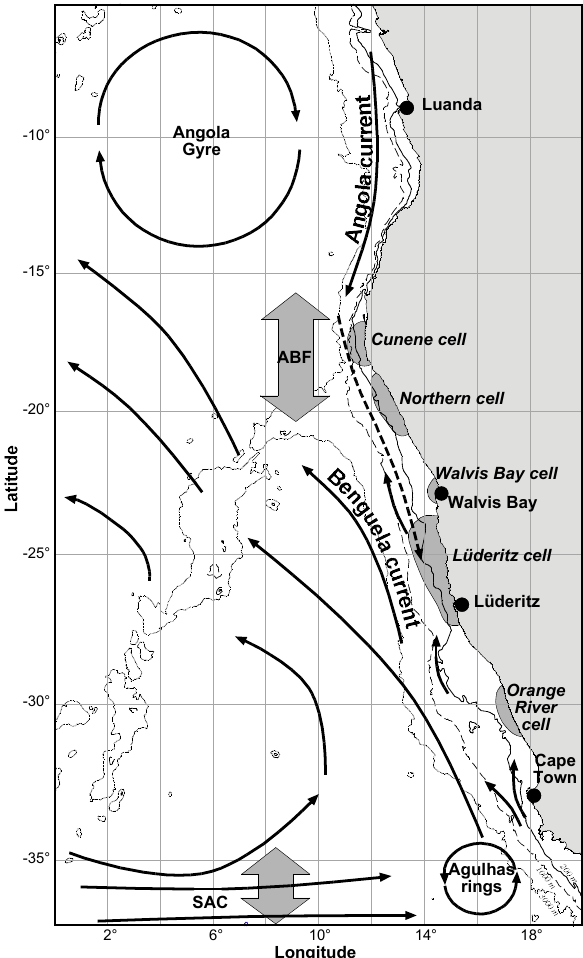
Fig. 8. The Benguela current upwelling area is stretching from 37 ◦ S to about 14 ◦ S. The northern boundary is formed by the seasonally-migrating Angola-Benguela front (ABF). In the south the Benguela Current originates from the South Atlantic Cur- rent (SAC) and the Agulhas current flowing around the southern tip of Africa and reversing to the east in the Agulhas ring. Five major upwelling cells can be found along the coast in the Benguela current area, namely (from south to north) the Orange river cell at 30 ◦ S, the L¨uderitz cell (the strongest upwelling cell worldwide), the Walvis Bay cell, the Northern Namibian cell, and the Cunene cell. The L¨uderitz upwelling cell divides the Benguela current ecosystem into a northern and a southern sub-system with different hydrographic regimes. The northern sub-system shows a pronounced OMZ mod- ulated by a seasonally-varying poleward undercurrent and onshelf transport of South Atlantic Central